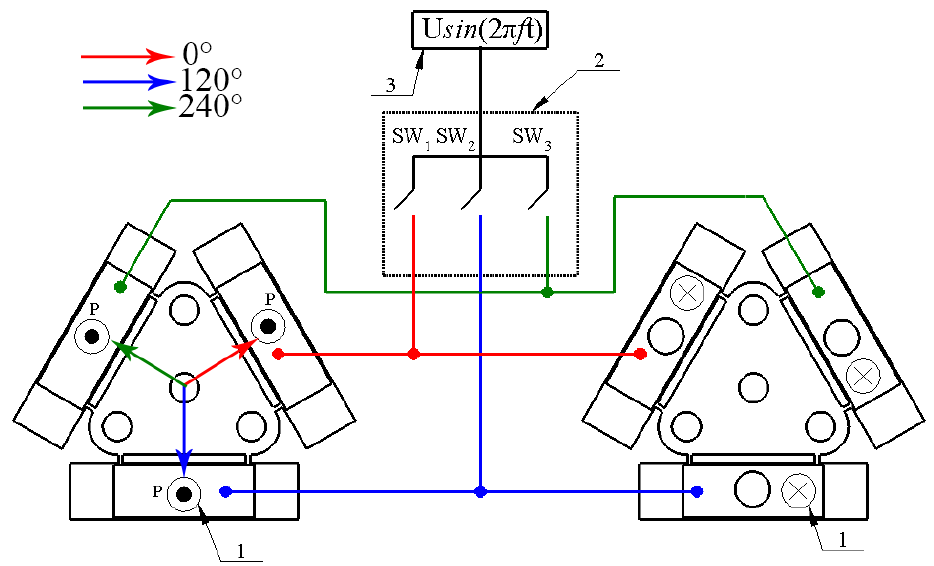
Figure 3. Excitation schematics of the platform; 1—direction of piezo ceramic polarization; 2—digi- tally controlled switch box; 3—signal generator.